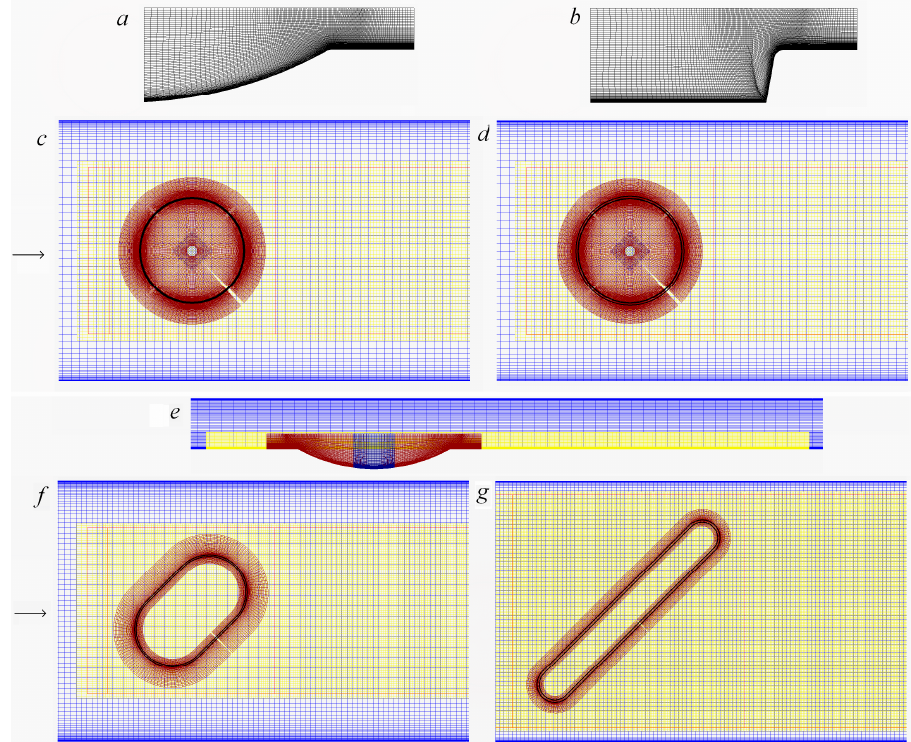
Figure 2. Spherical ( a ) and 10 ◦ -truncated conical ( b ) inserts in the multiblock structured grids in the narrow channel with single spherical ( c,e ), conical ( d ), oval ( f,g ) grids of different topology and width: Energies 2019 , 12 , x FOR PEER REVIEW ( c , d , f , g )—view from the heated wall; e —middle section of the channel; ( f–b ) = 0.731; ( g )—0.346.